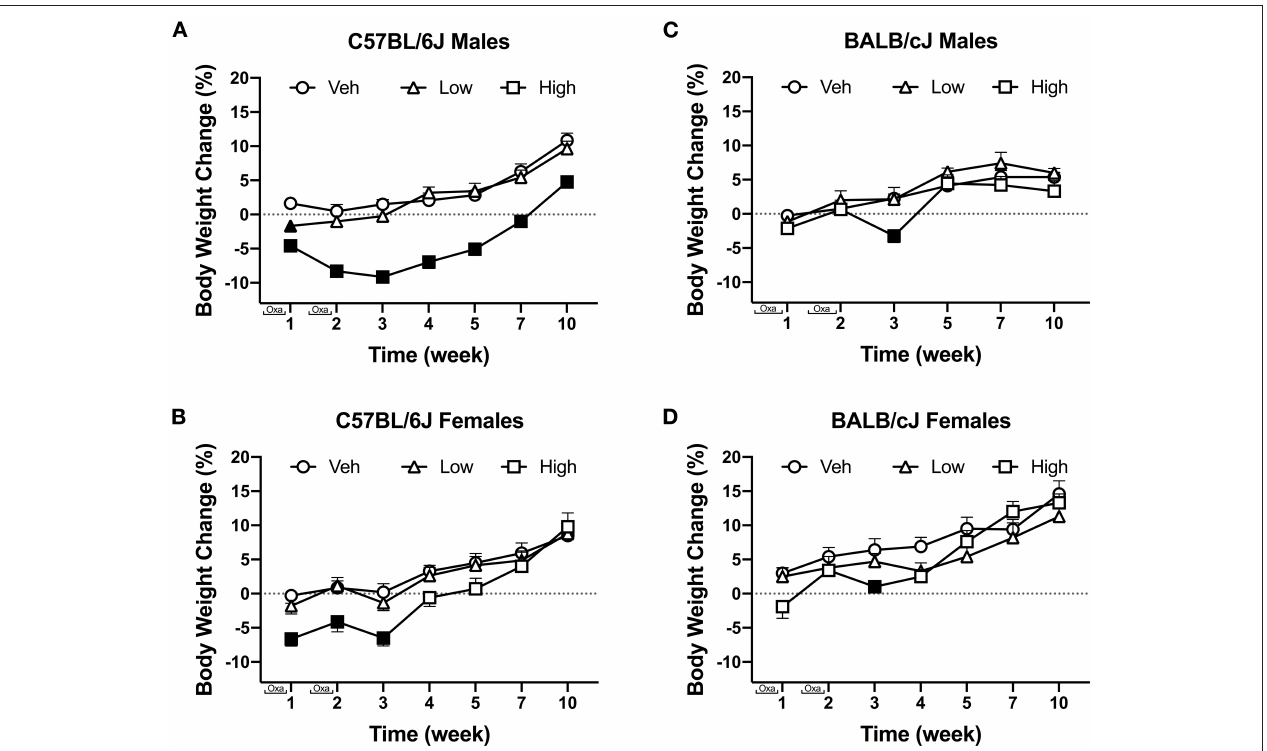
FIGURE 2 | The effect of oxaliplatin on body weight changes from baseline over the course of a 10-week observation period. C57BL/6J males ( n = 14/group) (A) C57BL/6J females ( n = 14/group) (B) BALB/cJ males ( n = 7–9/group) (C) BALB/cJ females ( n = 10/group) (D) . Filled points indicate times at which body weight was statistically different from vehicle. Values are expressed as mean ± SEM. Results were compared using two-way ANOVA (Treatment, Time as RM) for each strain and for each sex followed by Tukey’s post-hoc test, p <